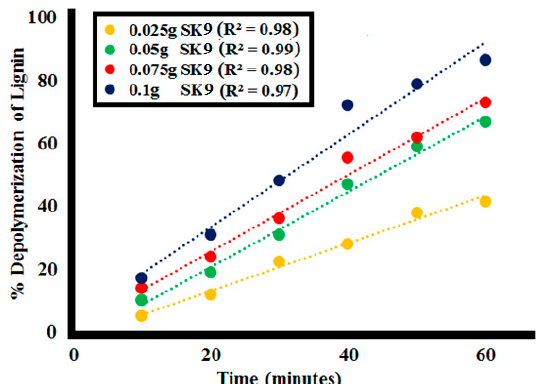
Figure 10. Correlation between %lignin ( L1 100ppm ) depolymerization by SK9 and the different catalyst doses at the different time intervals.